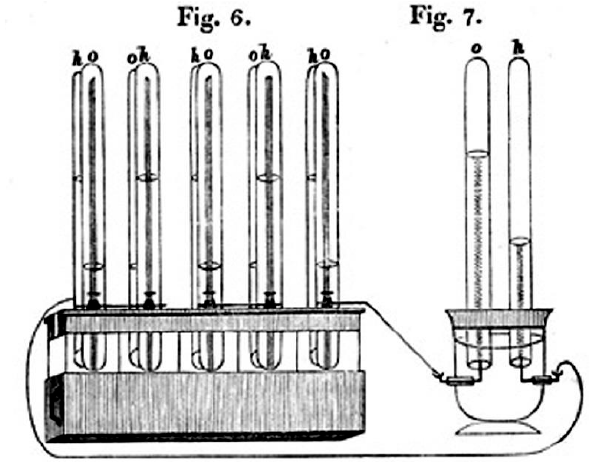
Figure 3. Grove’s apparatus for “the decomposition of water...by means of its composition.” W. R. Grove, Trans. Roy. Soc . 1843 , 133, plate V, p.